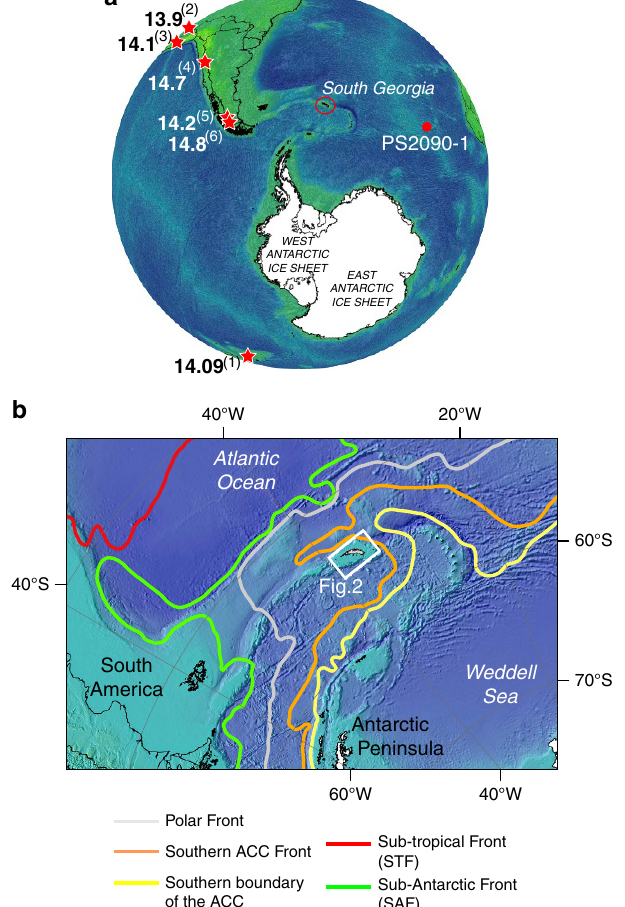
Figure 1 | Map of South Georgia. ( a ) Southern Hemisphere map showing sites where advances of glaciers during the Antarctic Cold Reversal have been recorded. Bold text are maximum ages (in ka B.P.) for the timing of maximum advance in each location. (1—ref. 28), (2—ref. 30), (3—ref. 31), (4—ref. 32), (5—ref. 33), (6—ref. 34). ( b ) Regional location map illustrating modern-day mean annual position of major Southern Ocean oceanographic fronts in relation to South